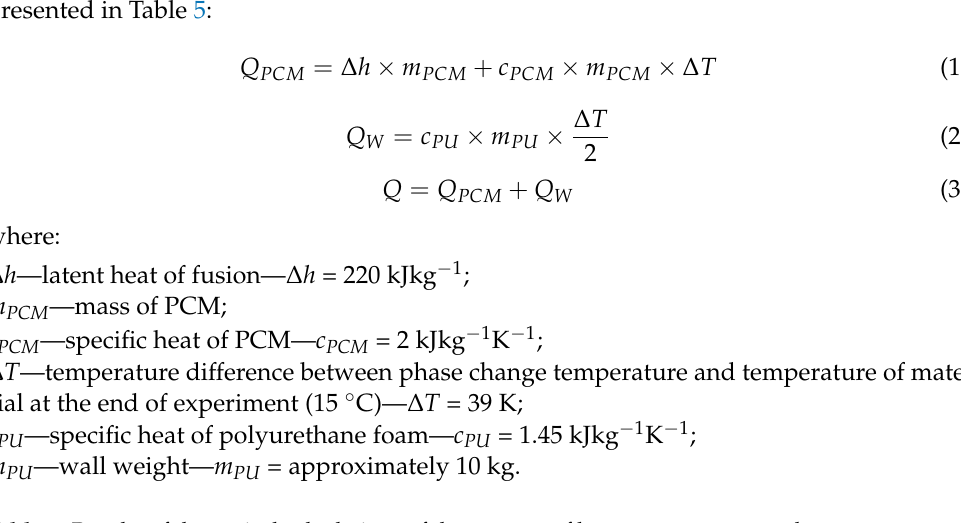
Table 5. Results of theoretical calculations of the amount of heat energy